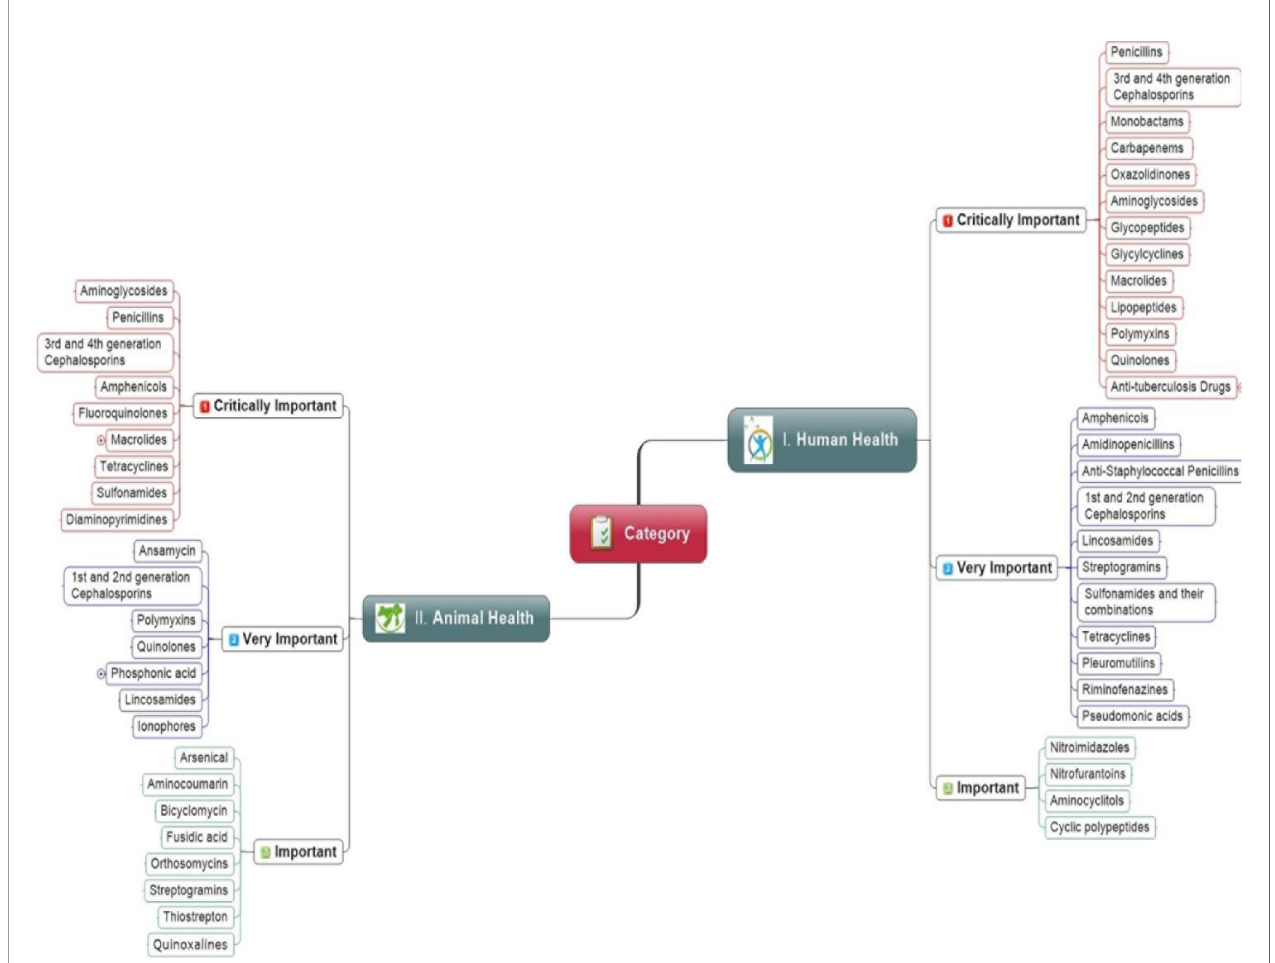
FIGURE 2 | Priority wise classi fi cation of antibiotic classes for human and animal health recommend by the World Health Organization and World Organization for Animal